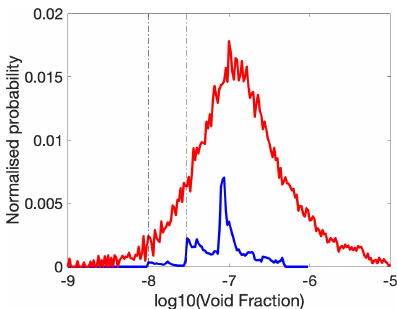
Figure 8. Normalised void fraction probabilities at 4m depth (blue) compared with the equivalent normalised probabilities at 2m depth (red). The dotted lines are the noise levels for station 3 (1 × 10 − 8 ) and station 6 (3 × 10 − 8 ). The final deployment is not included because it yielded so few data. This plot only shows data col- lected while the wind-wave Reynolds number was between 10 6 and 2 × 10 6 , and narrow bins are used to enable examination of the peak positions. The resonator data have been normalised to include the 90% of the time that the measured void fraction did not rise above the noise (and the data below the noise level is not represented